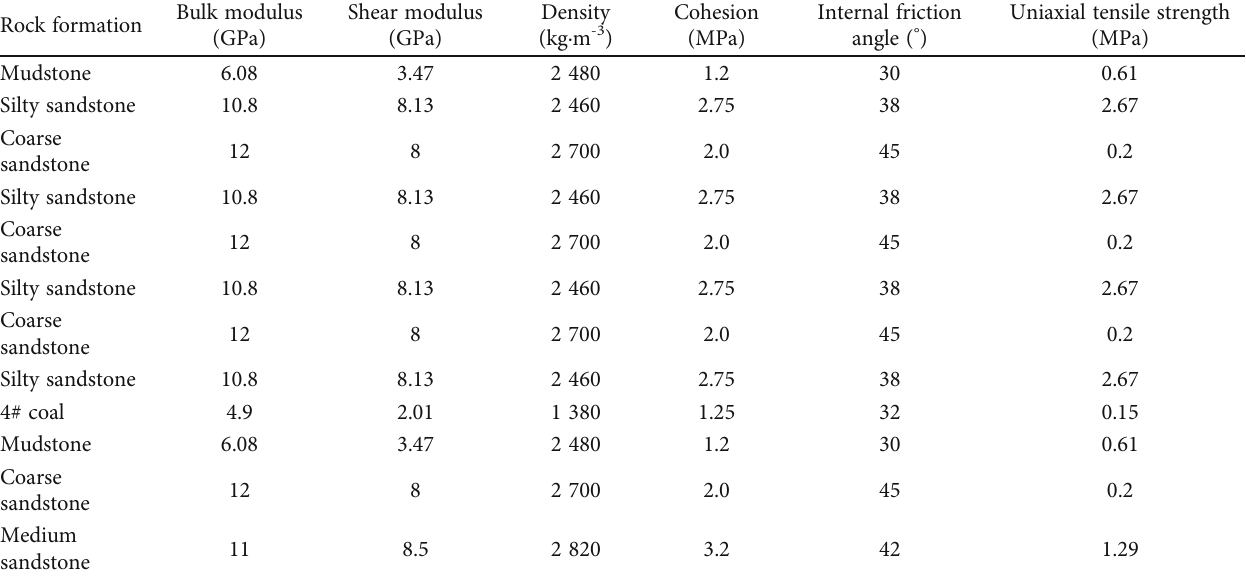
Table 1: Physical and mechanical parameters of surrounding